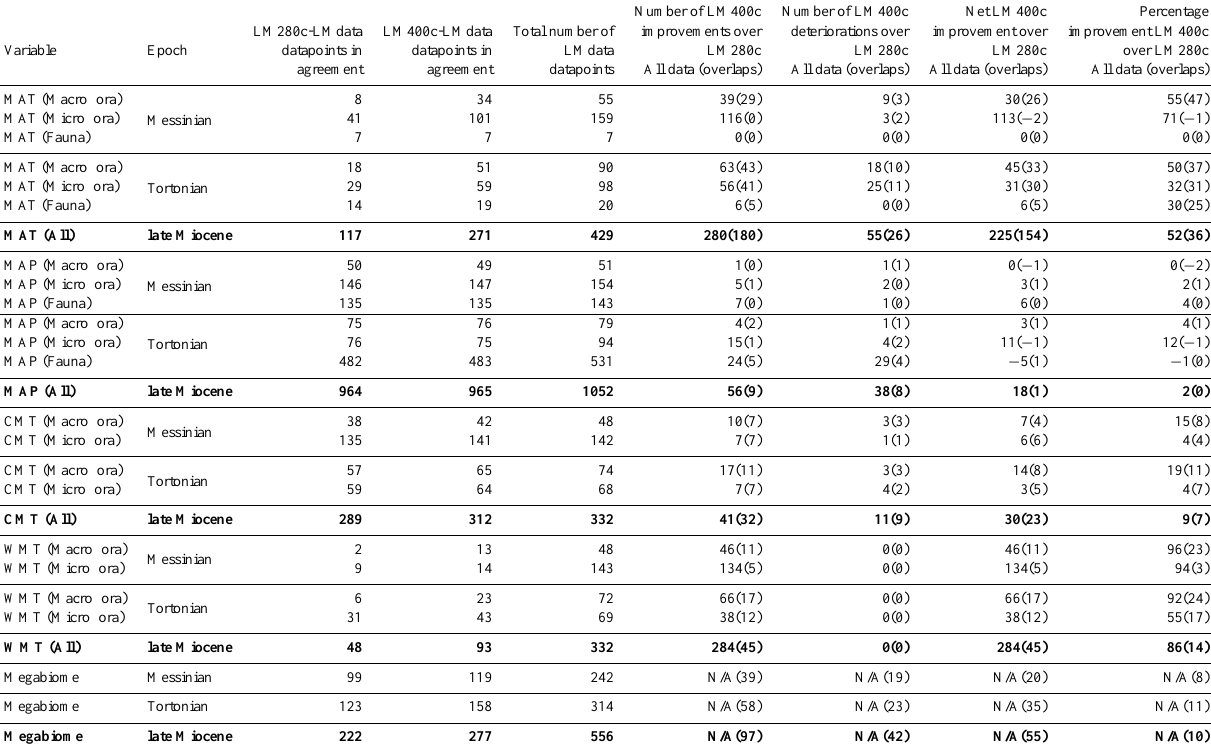
All data (overlaps)